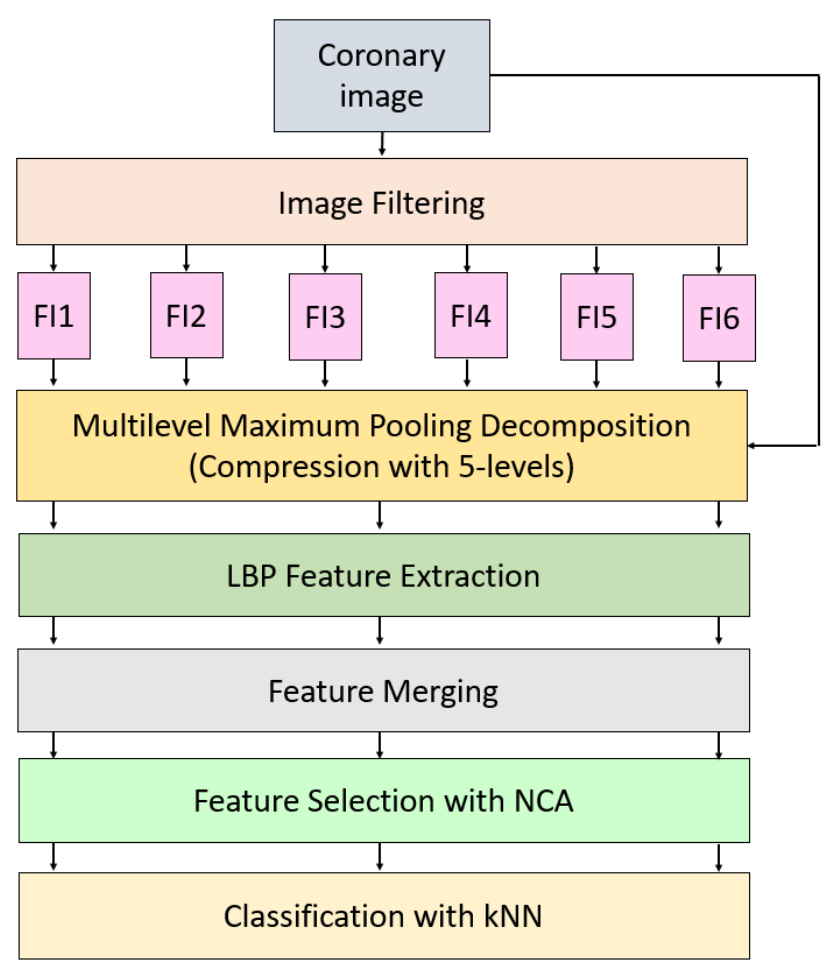
Figure 2. The proposed filtered images and multilevel maximum pooling-based LPB-NCA image classification model. Herein, FI1, FI2, . . . , FI6 denote filtered images.